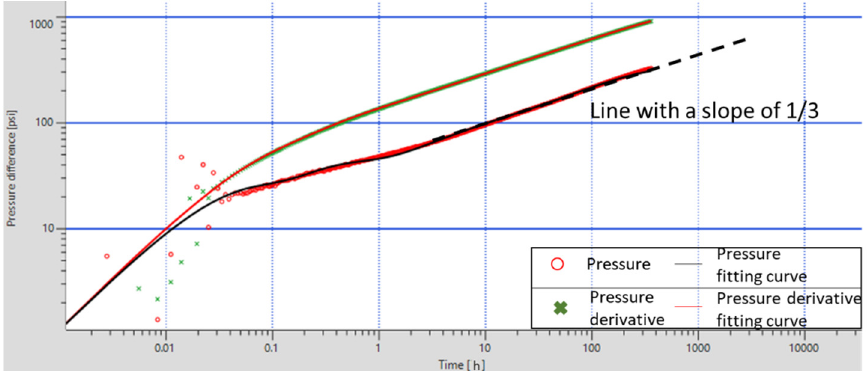
Figure 8. Horizontal well test curve with linear flow slope of 1/4.